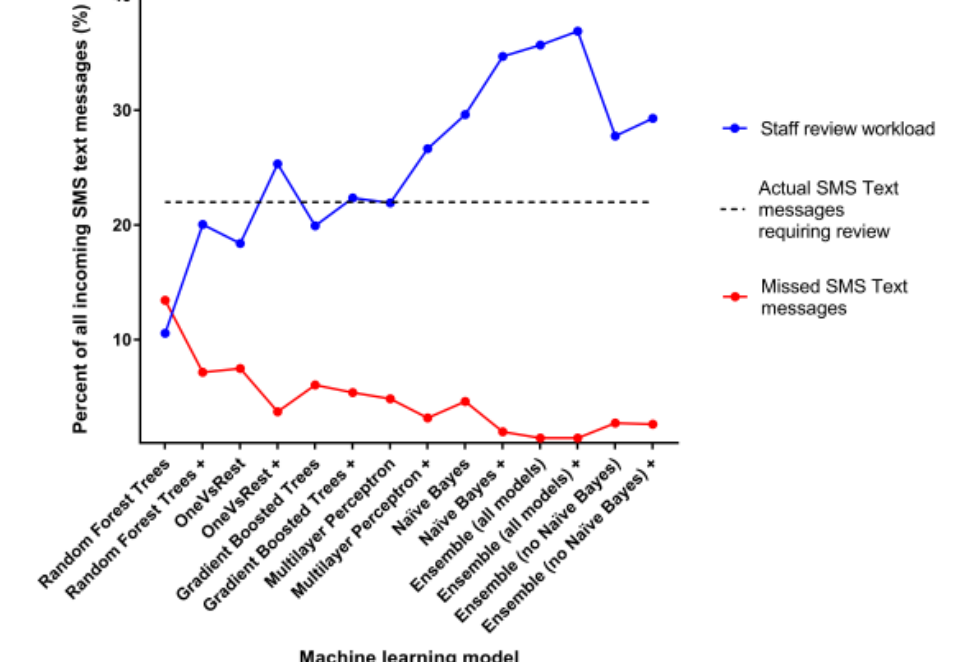
Figure 3. Staff workload versus missed messages according to machine learning model. Staff review workload: true positives plus false positives; +: model with heuristics